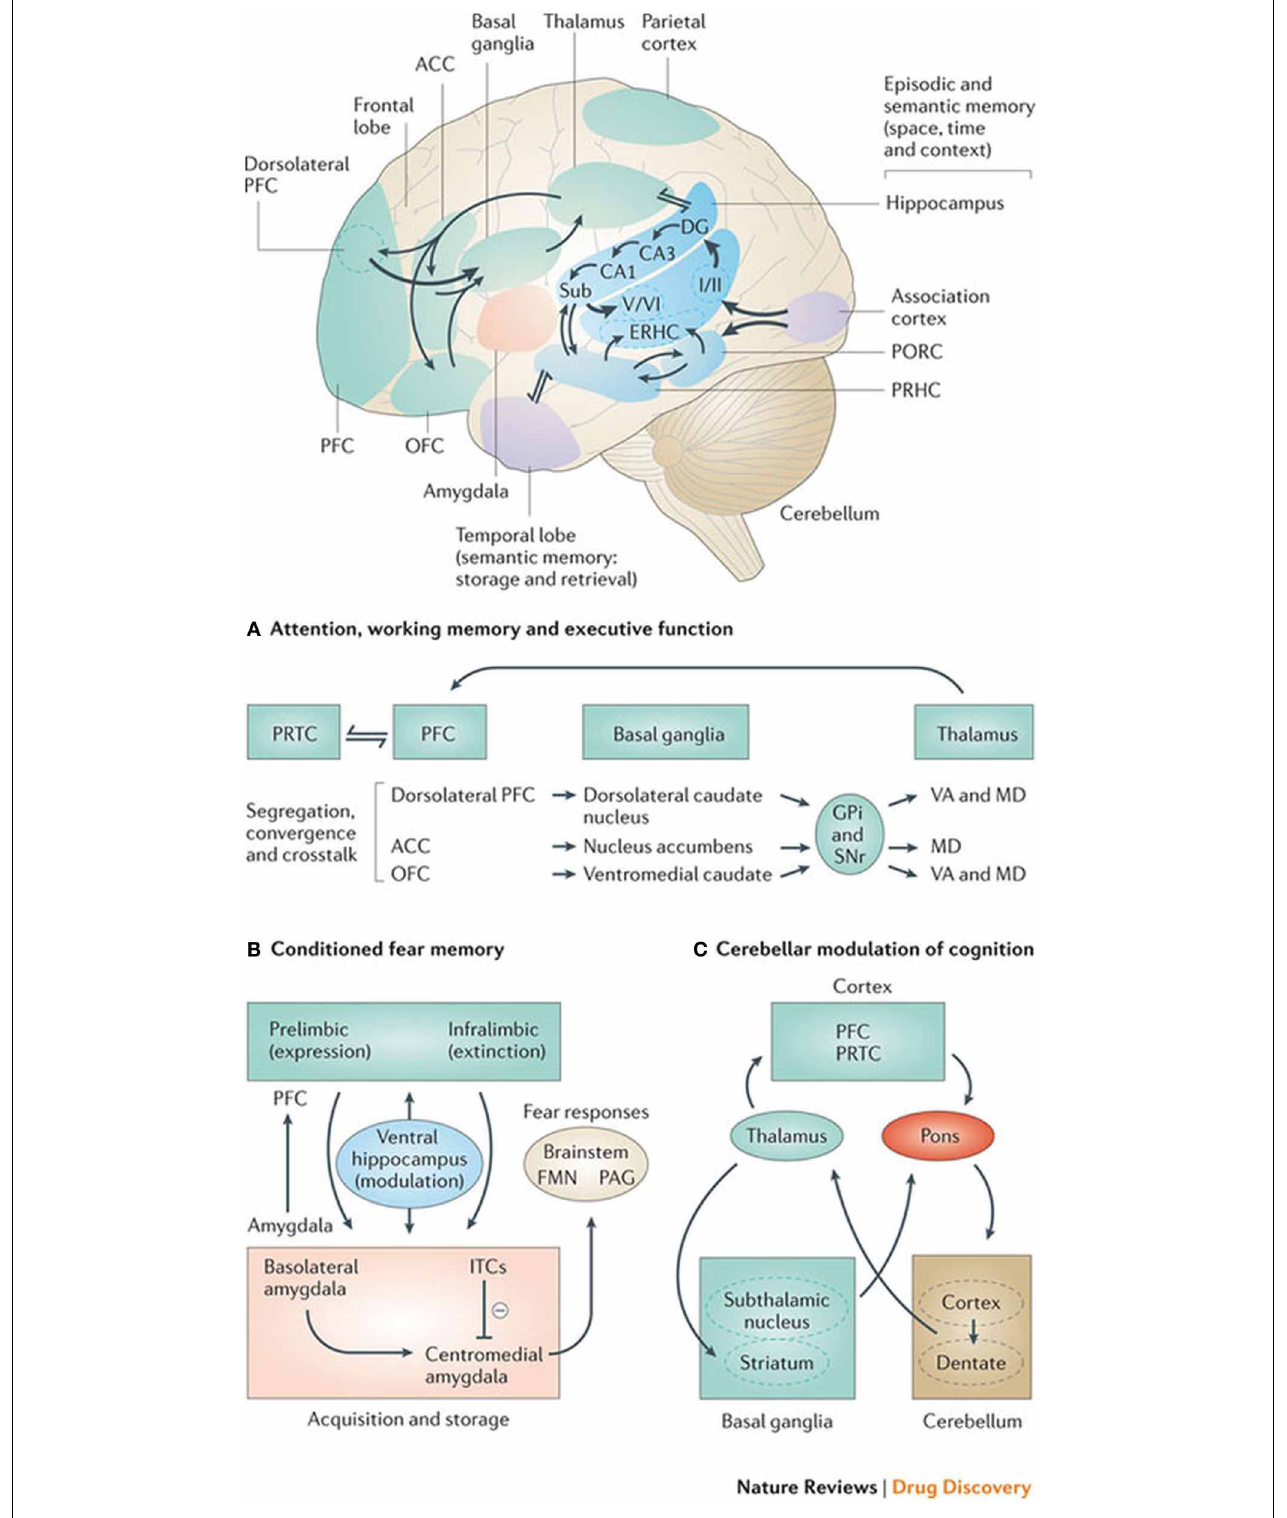
FIGURE 2 | Basal ganglia frontal lobe connectivities for motor cognitive interaction. All regions of the cerebral cortex project to the basal ganglia, but the output of the basal ganglia are directed toward the frontal lobe, particularly the premotor and supplementary